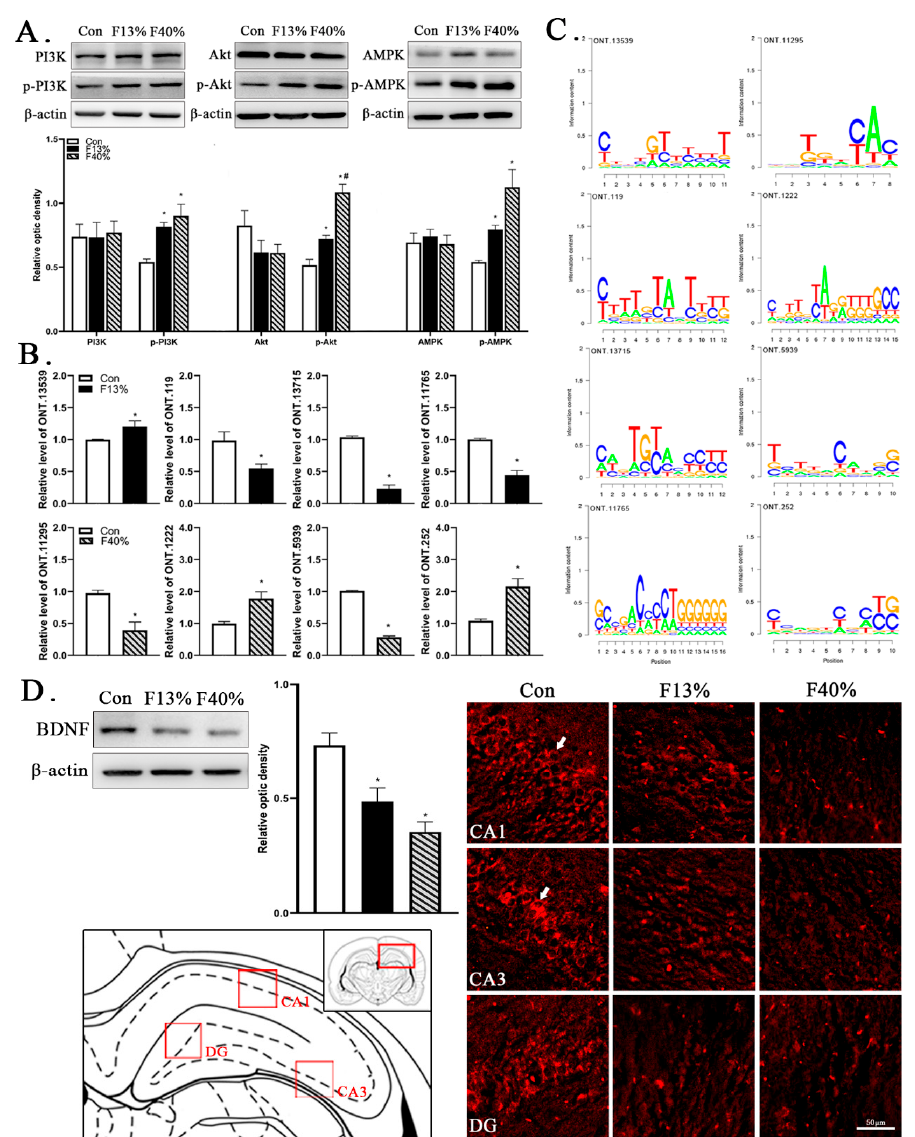
Figure 7. Transcriptome sequencing validation experiments and Transcription factor binding site (TFBS) prediction. ( A ) Representative immunoblots and densitometry analysis of PI3K, p-PI3K, Akt, p-Akt, AMPK, and p-AMPK expression levels in the total hippocampus. ( B ) Quantitative expressions of eight DElncRNAs. ( C ) TFBS of eight DElncRNAs. ( D ) Representative microscopic images of BDNF (red) IF staining in hippocampus CA1, CA3, and DG regions. White arrows indicate representative specific expression. Note: Every group n = 6; each bar represents mean ± SEM; * p < 0.05 (vs. control group); # p < 0.05 (vs. 13% fructose). In microscopic images, scale bar = 50 µ m; magnification = × 200. Con, control group; F13%, 13% fructose group; F40%, 40% fructose group.